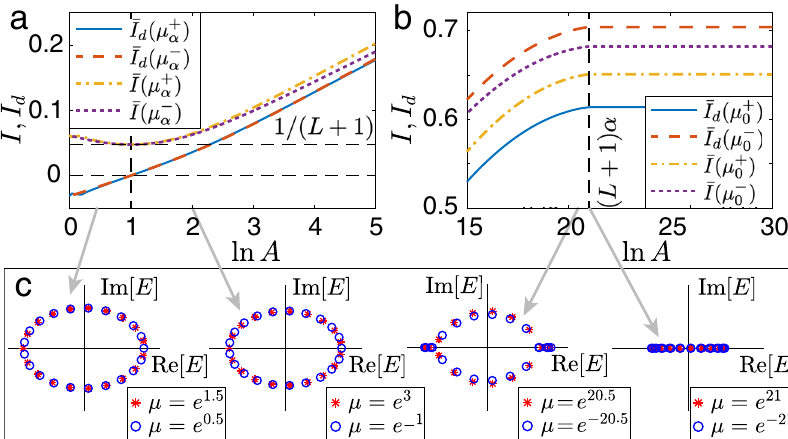
P I = N and Fig. 3 Duality between strong and weak impurity strengths. a and b Average inverse participation ratios (IPRs) de fi ned as (cid:2) I ð μ Þ ¼ n P P P n (cid:2) I ð μ Þ ¼ I = N , with I = ∣ ψ ∣ 4 and I = x − x ) ∣ ψ ∣ 4 /( L /2), ψ n th eigenstate at x , N and L the total number of n x , n d , n c x , n x , n the wave-function value of the d n ; d n x x ( states and lattice sites, and x c = L /2 being the center of the system. The impurity strength μ is parametrized by a variable A , i.e. μ ¼ μ ± α ¼ e α A ± 1 and μ ¼ μ ± ¼ A ± 1 for ( a ) and ( b ), respectively. In ( a ), μ þ μ (cid:2) A values, μ þ and μ (cid:2) form a pair of α and α form a pair of duality, whereas in ( b ) with much larger 0 0 0 duality. The summation of n runs over all continuous eigenstates, and N = L − 1 ( L + 1) is their total number in the presence (absence) of the pair of isolated states E iso ≈ ± μ . Colors of the curves indicate IPRs for different choices of μ . Blue and orange curves are almost identical in ( a ). c Spectra with dual parameters, as indicated by the gray arrows. A phase transition to OBC-like line-spectrum at μ = e ±( L + 1) α = e ±21 , with the parameters L = 20 and α = 1. The duality indicated in ( a ) is further con fi rmed by the identical spectra (blue circles and red stars) of μ ¼ μ ± α (with α = 1), at A = 0.5 and A = 2 for the left two panels, respectively. Similarly, the two panels on the right depict the duality between μ ¼ μ ± indicated in ( b ), for the two points of A = 20.5 and A = 21. 0